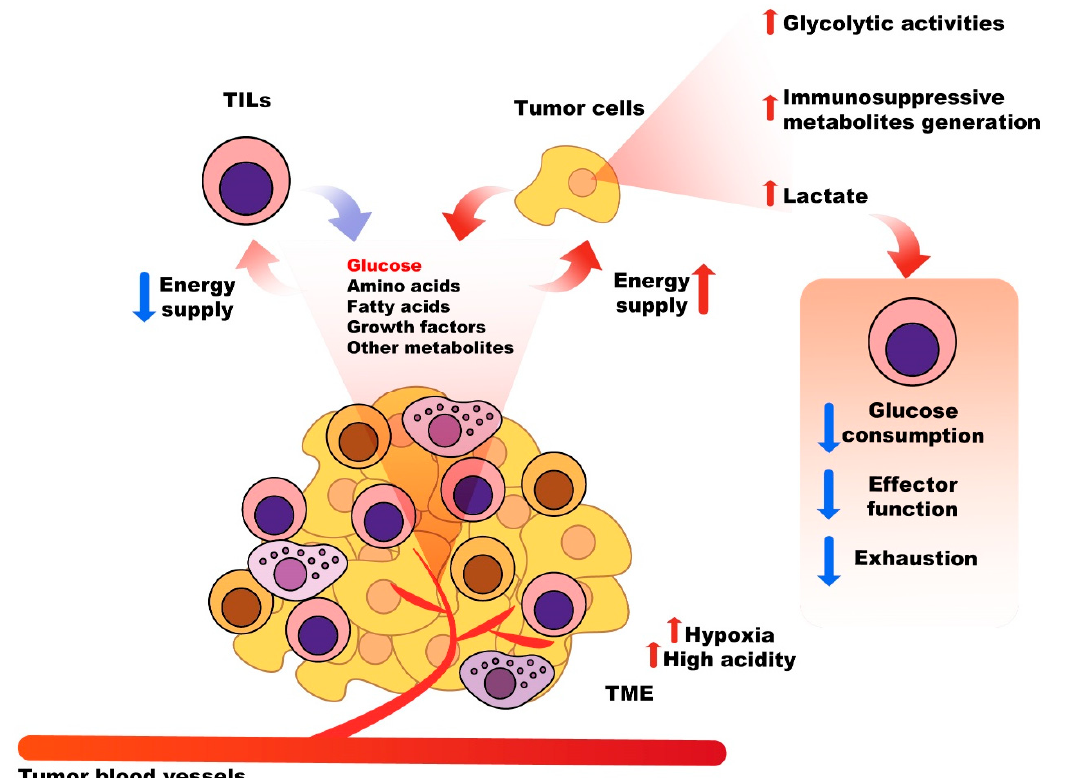
Figure 2. Metabolic competition between cancer cells and immune cells in the TME. There is a competition between tumor cells and immune cells to take up glucose, amino acids, fatty acids, growth factors, and other metabolites in the TME. The most critical nutrient consumed and absorbed by tumor cells is glucose, which also serves as an essential energy substance for the differentiation, activation, and function of infiltrated immune cells in the TME, such as TILs. Competitive uptake of glucose by tumor cells to suppress the function of TILs. Increased glycolytic activities of tumor cells, and generated metabolites, such as lactate, can suppress glucose consumption by TILs, and their exhaustion.